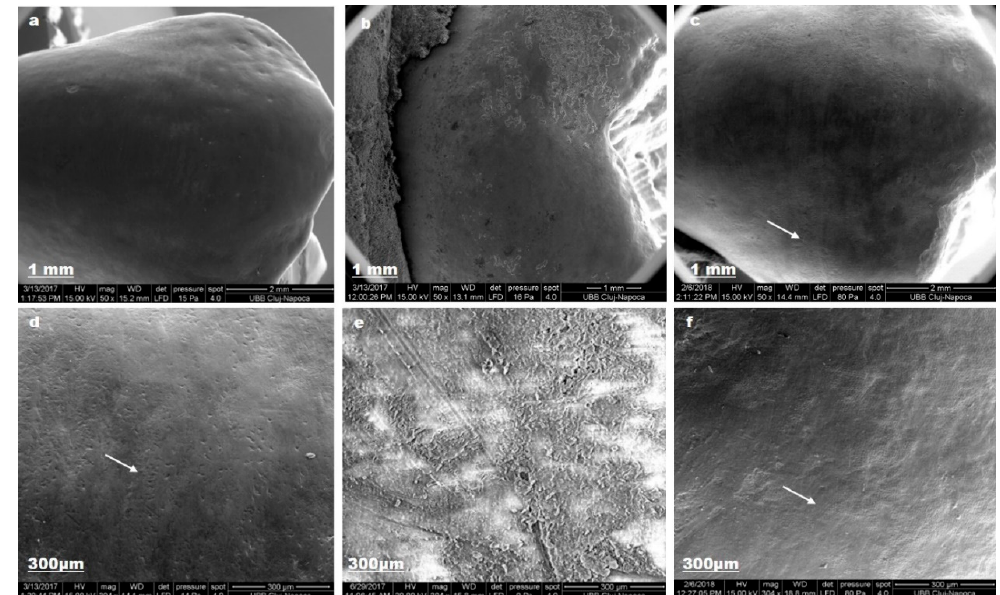
Figure 7. Lacalut_wr SEM images for sound enamel after T1 ( a , d ), demineralized enamel surface ( b , e ), enamel surface after T3 ( c , f ).